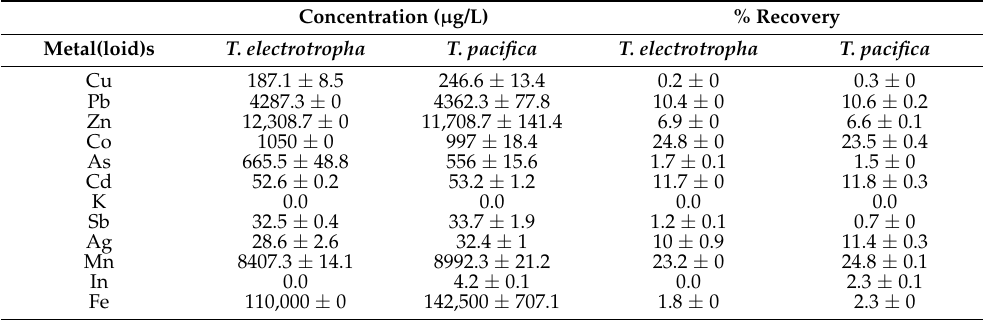
Table A7. Concentrations and percentages of the metal(loid)s extracted from the Neves Corvo waste rock (NC_01) by the spent nutrient mediums of T. electrotropha and T. pacifica at high temperature and pressure. Values are the average of duplicate flasks ± standard deviations.